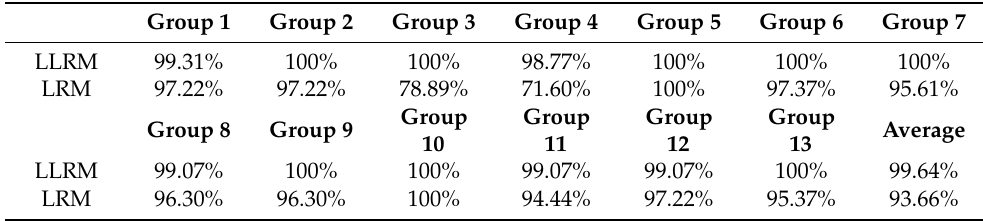
Table 5. Comparison of recognition accuracy between LLRM and LRM using SNV data.